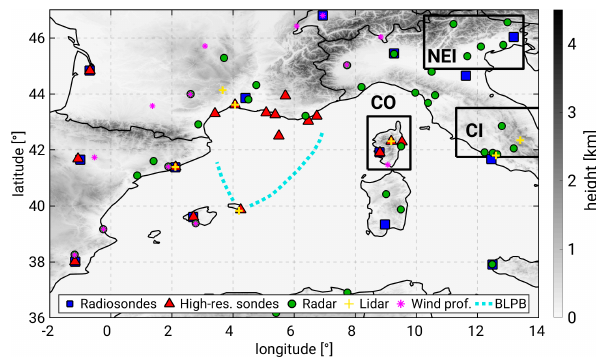
Figure 1. Location of selected experimental setup during IOP16 on 25–28 October 2012, including radiosondes and high-resolution sondes, radar, lidar, wind profilers, and boundary layer pressurized balloons (BLPBs). The position of the GPS receivers can be found in Fig. 3d. The locations of the CO, NEI, and CI subdomains are indicated with black